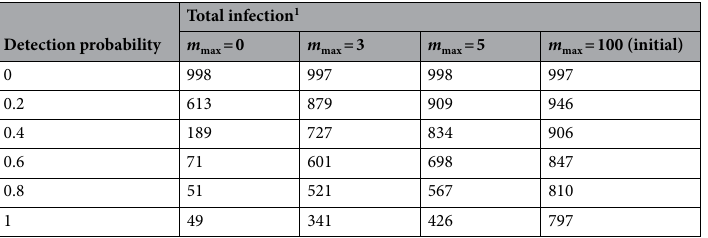
Table 1. Dependency of the number of infections on mobility restriction, detection probability, and transmission probability ( N = 1000 People, M = 2000 sites, 0.8 transmission probability ( T.P. ), mobility restriction applied at 1% (= 10 people)). 1 Total number of infected people at the end of the simulation.